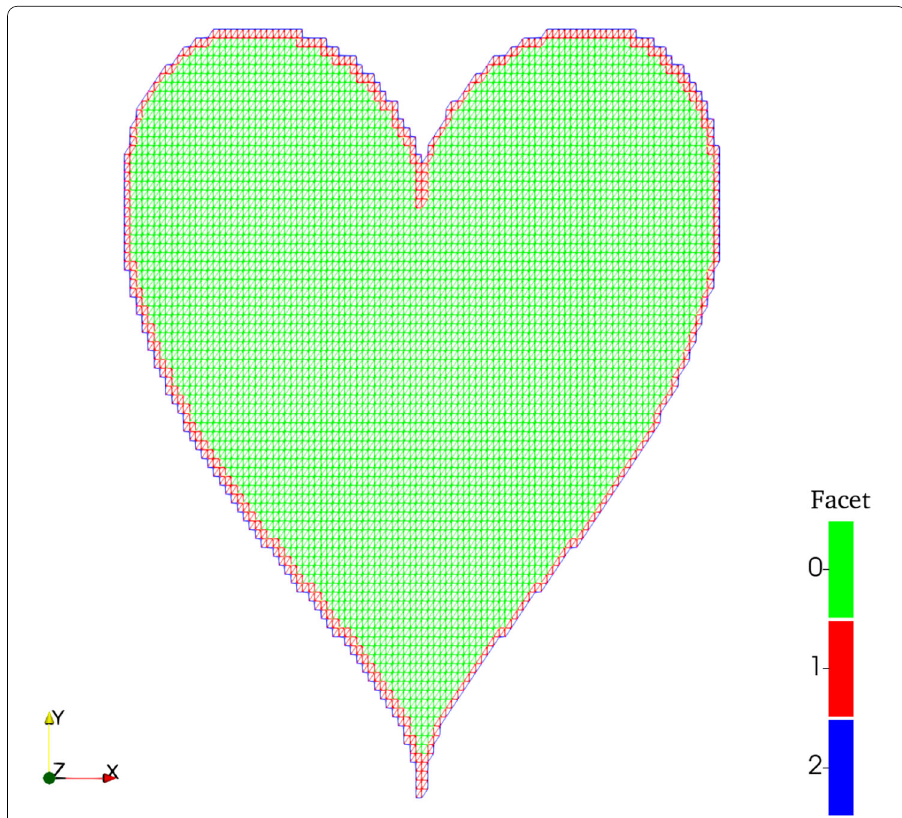
Fig. 4 We can see the fictitious domain ˜ (cid:3) for the heart shaped function, and the facets marked. In red the set of facets F G where we apply the stabilization term j ([ U ] n + 1 ,v )